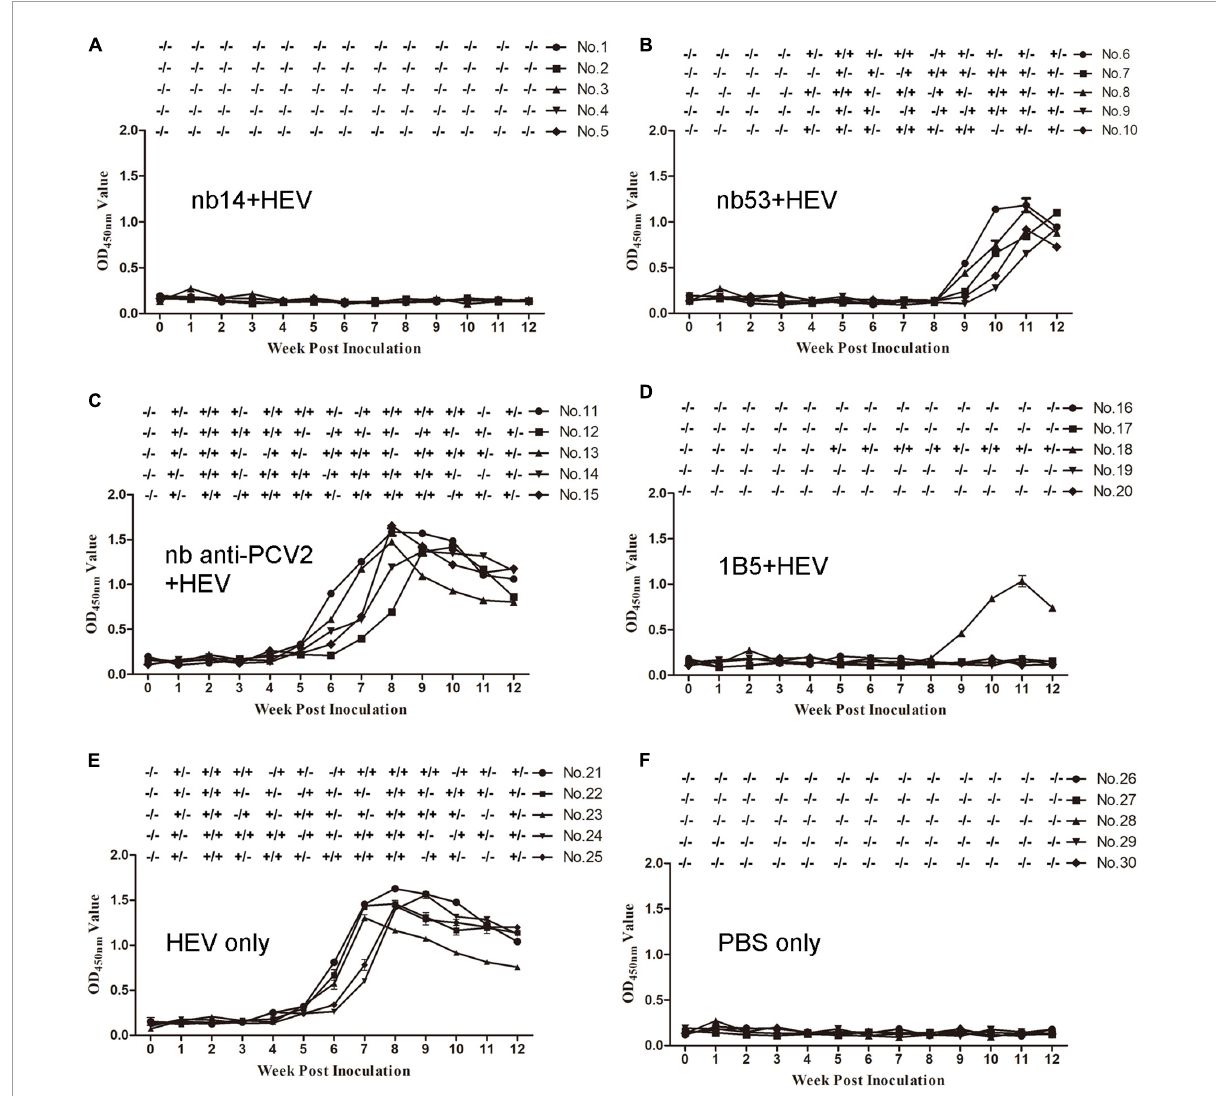
FIGURE4 Analysis of viremia, fecal shedding, and seroconversion in SPF rabbits inoculated with different virus mixtures. (A–D) Rabbits inoculated with swine HEV mixed with nb14, nb53, nb anti-PCV2, and 1B5. (E,F) Rabbits inoculated with only CHN-SD-sHEV or PBS. Serum and fecal samples were collected before inoculation and weekly. ± , positive or negative HEV RNA in fecal or serum